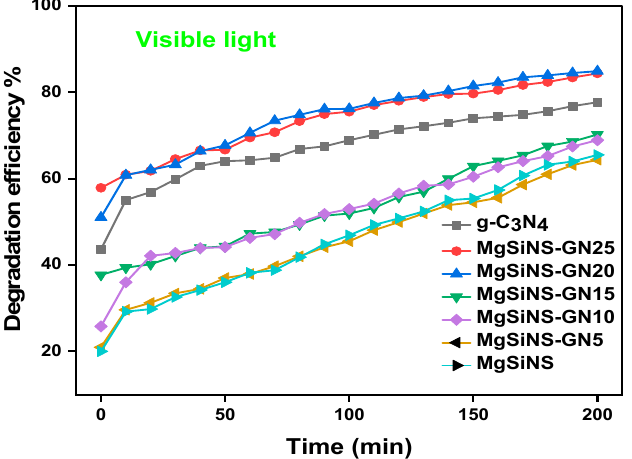
Figure 7. The MB photodegradation performance over time using visible light for all the prepared samples.